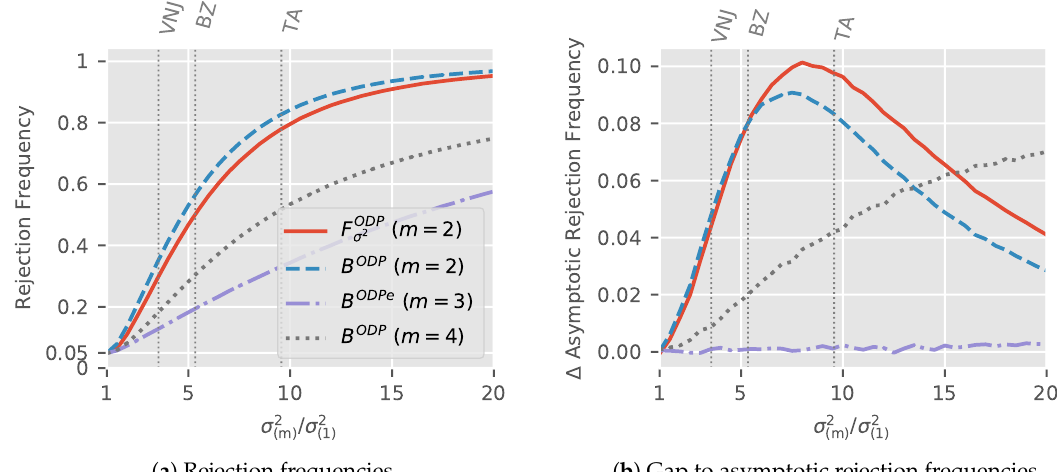
Figure 7. Power gap for log-normal dispersion tests based on sub-sample structures from empirical applications. Empirical maximum to minimum ratios indicated by horizontal lines. Rejection frequencies shown in ( a ), gap to asymptotic rejection frequencies in ( b